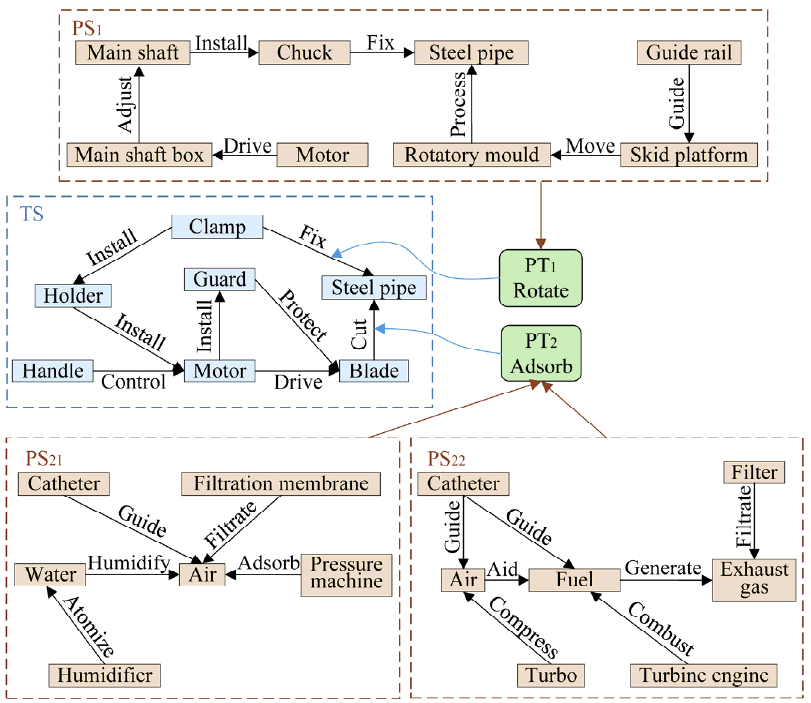
Figure 15. Solution mapping.